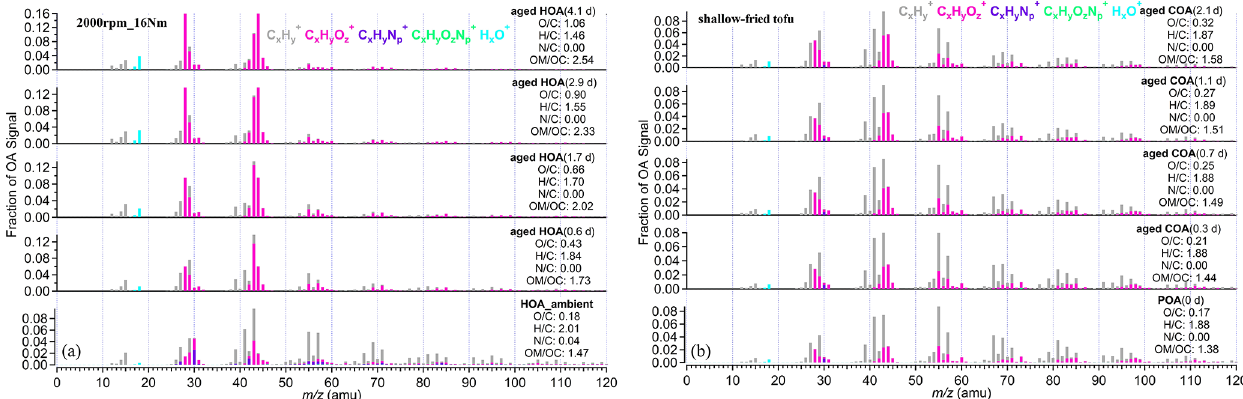
Figure 2. (a) The mass spectra of HOA and aged HOA oxidation under four different OH exposures at the same running condition (2000rpm; 16Nm). (b) The mass spectra of primary COA and aged COA oxidation of different OH exposure for shallow-fried tofu. The EPA was obtained from offline methods according to SO 2 decay shown in Table S3. The elemental compositions were estimated by the improved ambient updated method (Canagaratna et al.,